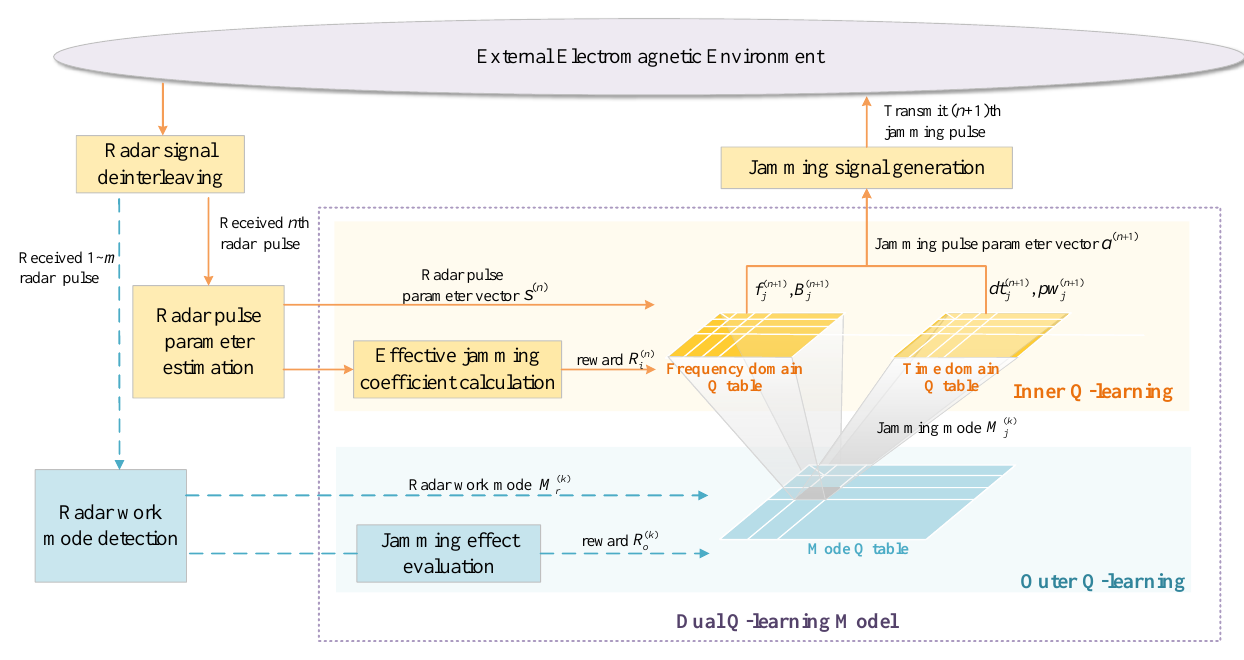
Figure 2. Jamming decision-making based on DQL model: During a jamming round, the radar work mode is discerned with the earliest received m radar pulses. Once a new radar mode M recognized, it is sent to the outer Q-learning module. Then the jamming mode M to time domain Q table and frequency domain Q table in the inner Q-learning module. According ( k ) ( k − 1 ) to M r and M r , the jamming effectiveness of last jamming round is evaluated, with which the outer Q table can be updated according to Equation (11). When receiving the n th ( n > m ) radar pulse, the radar pulse parameter vector s ( n ) is obtained through parameter estimation. Then the jamming parameters are selected to constitute the parameter vector a ( n + 1 ) , and the jamming signal will be generated. According to s ( n ) , the two effective jamming coefficients are evaluated, with which the inner Q table can be updated according to Equation